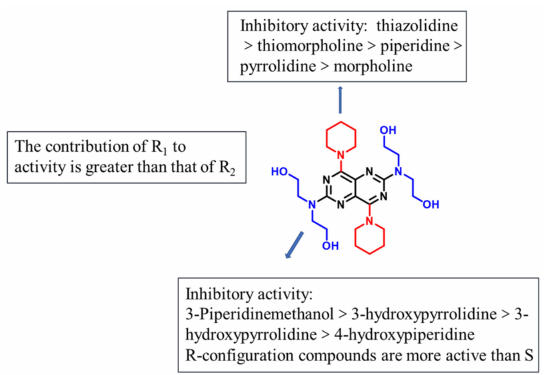
Figure 2. The structure–activity relationship of designed compounds.